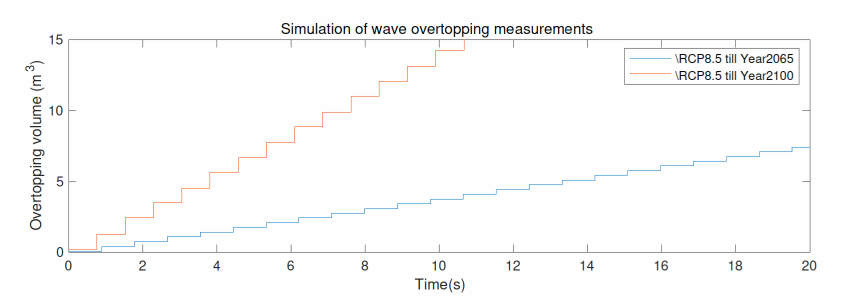
Figure 13. Overtopping volume over the double-dike defence structure under the RCP6.0 scenario.